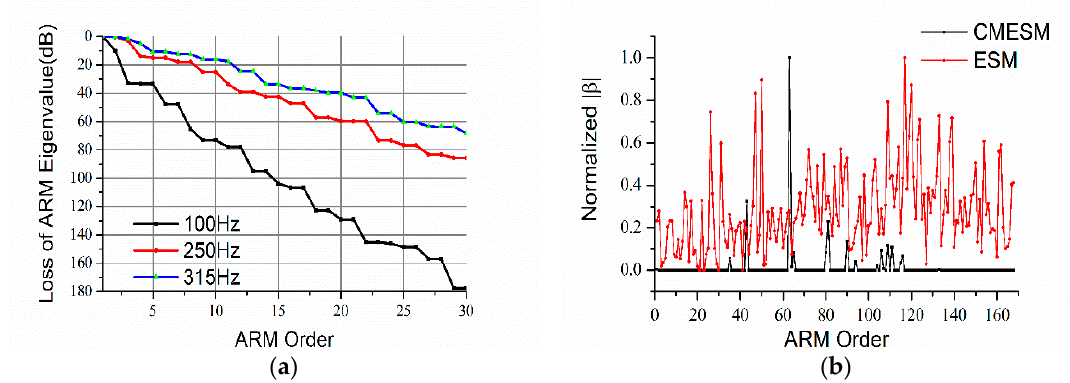
Figure 7 . ( a ). Attenuation curves of ARM eigenvalues with the increase of the ARM order at different frequencies (unit: dB); ( b ) comparison of the normalized modal expansion coefficient sparsity between ESM and CMESM at the frequency of 100 Hz.